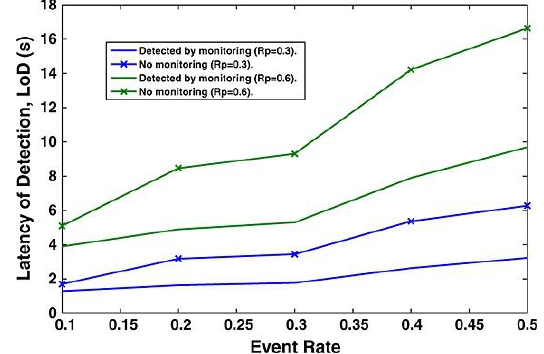
Fig.13. Impact of event rate on latency of detection